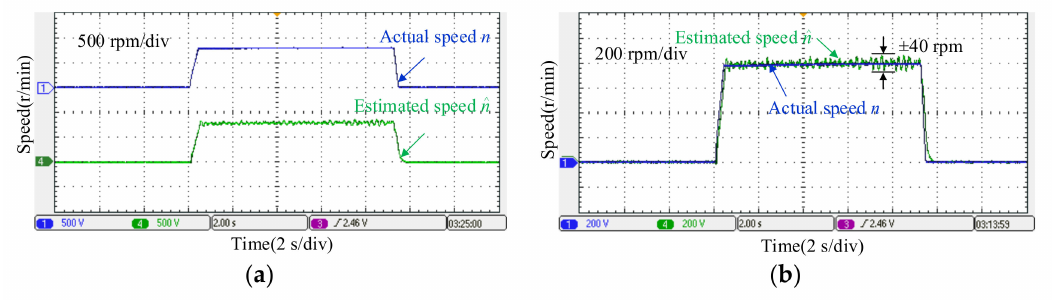
Figure 12. Actual speed and estimated speed employing the traditional second-order SMO method when the motor operates at 800 rpm ( a ) separated waveform; ( b ) overlapped